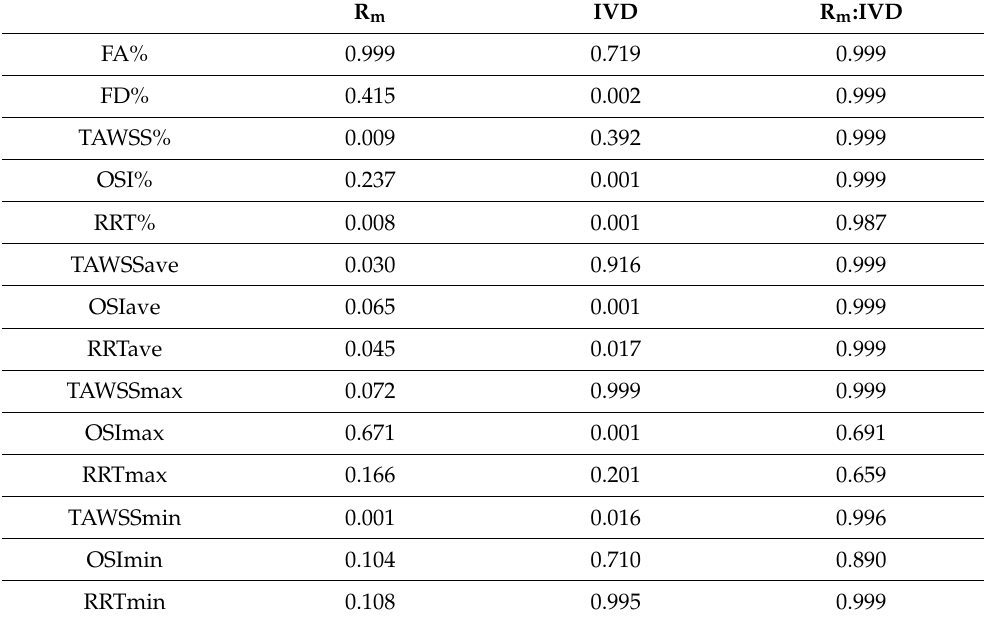
Table 4. p -values derived from heteroscedasticity- and outlier-robust, trimmed-mean-based ANOVA analyses for the effects of alternative inlet velocity distributions and rheological models at the hemodynamic behavior of real aneurysm geometries. Response variables related to hemodynamic behavior are shown in rows with the two main factors and their interaction in columns. p -values very close to zero, shown in bold, provide strong evidence against the null hypothesis of equal means across factor groups.